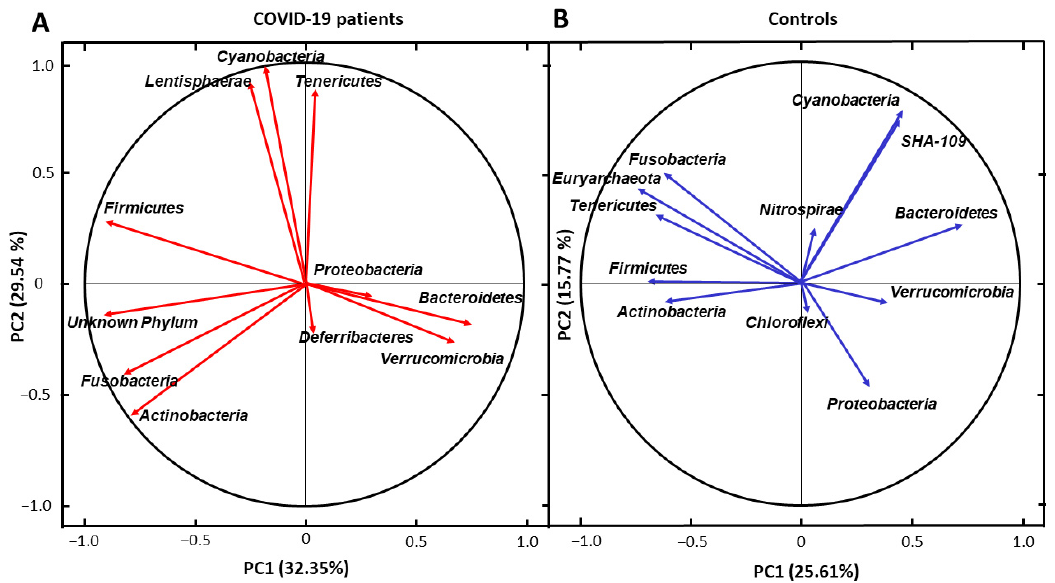
Figure 4. Projection of the microbial composition at phylum level on the two-dimensions biplot for COVID-19 patients ( A ) and healthy controls ( B ). PC1—principal component 1, PC2—principal com- ponent 2.